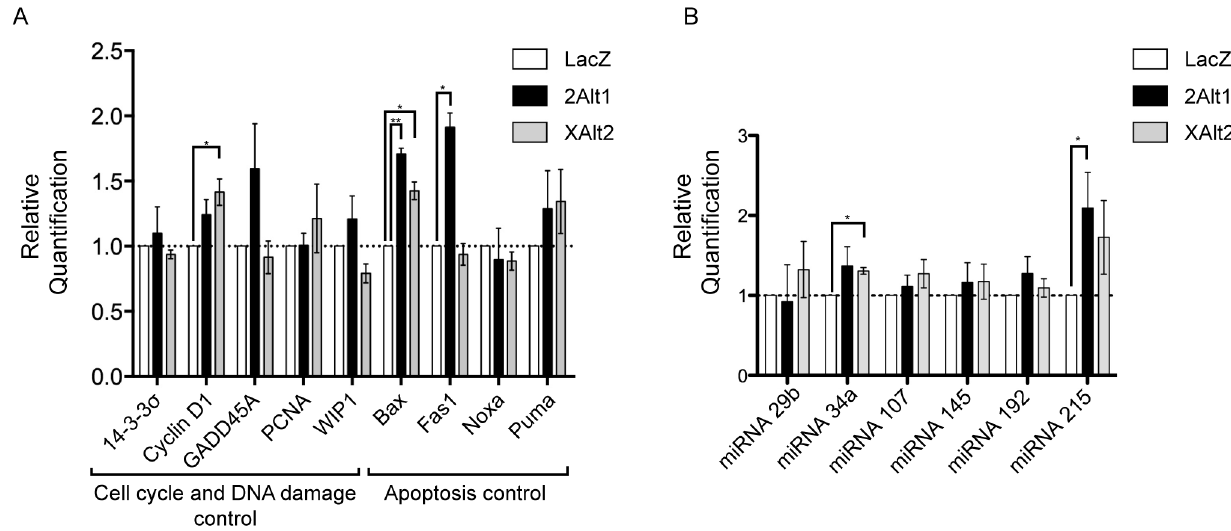
Figure 4. MDM2-ALT1 and MDMX-ALT2 lead to the activation of subtly different subsets of p53 transcriptional targets. A. MCF7 cells transfected with myc-tagged LacZ, or MDM2-ALT1 (Alt1) or MDMX-ALT2 (XAlt2) were examined for mRNA levels of a panel of 9 p53 transcriptional targets using quantitative real-time PCR and were normalized to LacZ-expressing cells. The bar graphs represent the relative quantification (2 2 DD Ct ) values from at least 3 independent experiments and each consisting of 3 technical replicates. The error bars represent standard error means (SEM). B. qRT-PCR was used to compare the relative levels (2 2 DD Ct ) of miRNA targets of p53 between cells over-expressing LacZ or MDM2-ALT1 or MDMX-ALT2. Here also a minimum of 3 independent trials was performed with 3 technical replicates each. The error bars represent standard error means (SEM). * represents p , 0.05 and ** represents p , 0.01 in all cases.